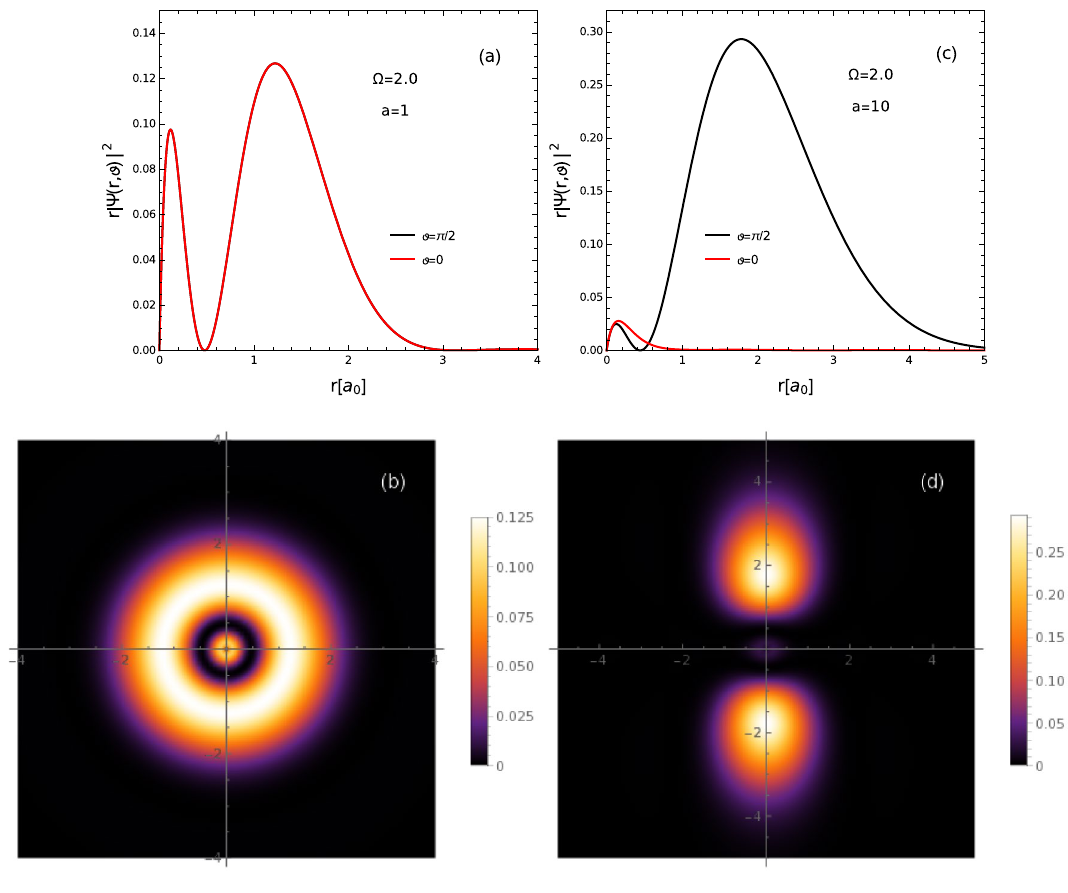
Figure 7. Electron-hole density function (intracule density) for first excited state of Mott-Wannier exciton for different levels of the deformation of confining potential: ( a ), ( b ) isotropic case ( a = 1 ); ( c ), ( d ) anisotropic case a = 10